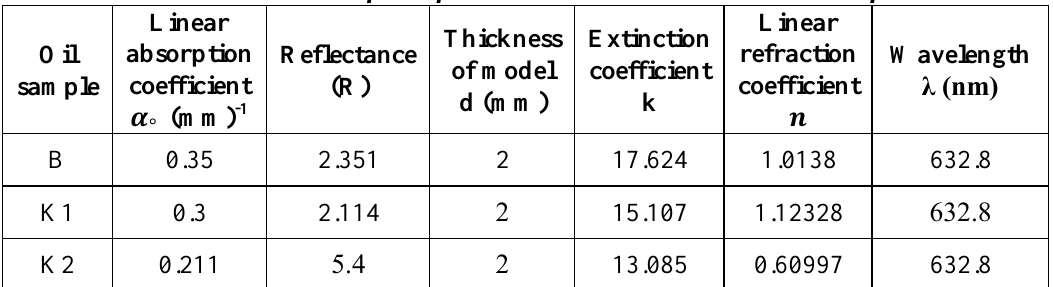
Table 2: The linear optical parameters for the three crude oil